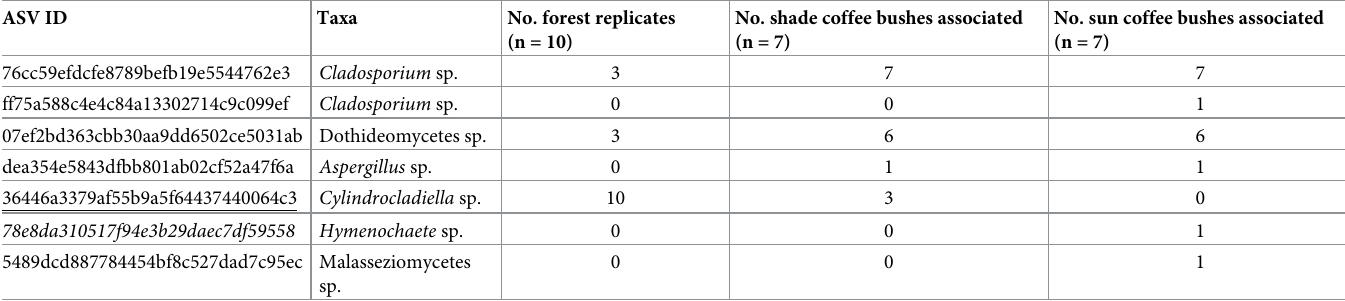
Table 2. Fungal ASVs from biofertilizer detected in forest and coffee soils. If the fungal ASV was detected in any sample (e.g., drip line, upper) from a coffee bush then the fungal taxa was considered associated with that coffee bush. Two ASVs could be categorized into a trophic mode using FUNguild and our criterion for assignment: one was a ‘probable’ pathotroph (ASV ID underlined) and one was a ‘probable’ saprotroph (ASV ID italicized). ASV ID Taxa